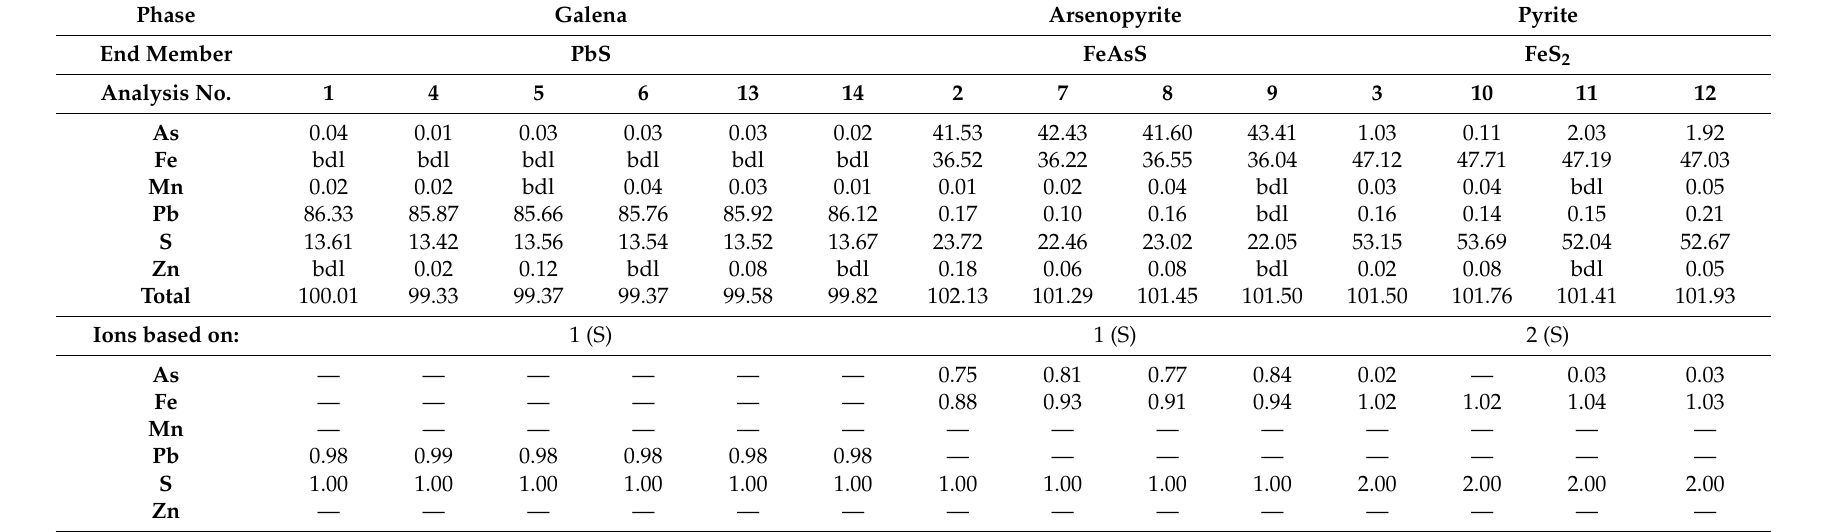
Table 2. EPMA analyses of mineral phases present in Stratoni PbS concentrate (bdl: below detection limit). Phase Galena Arsenopyrite